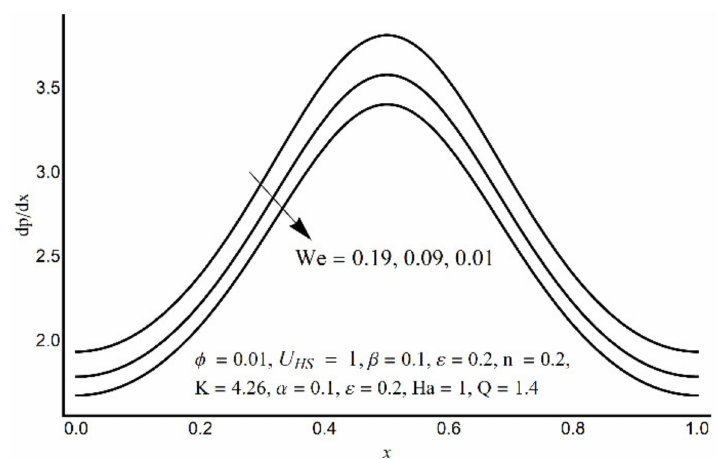
Figure 8. Pressure gradient at varying